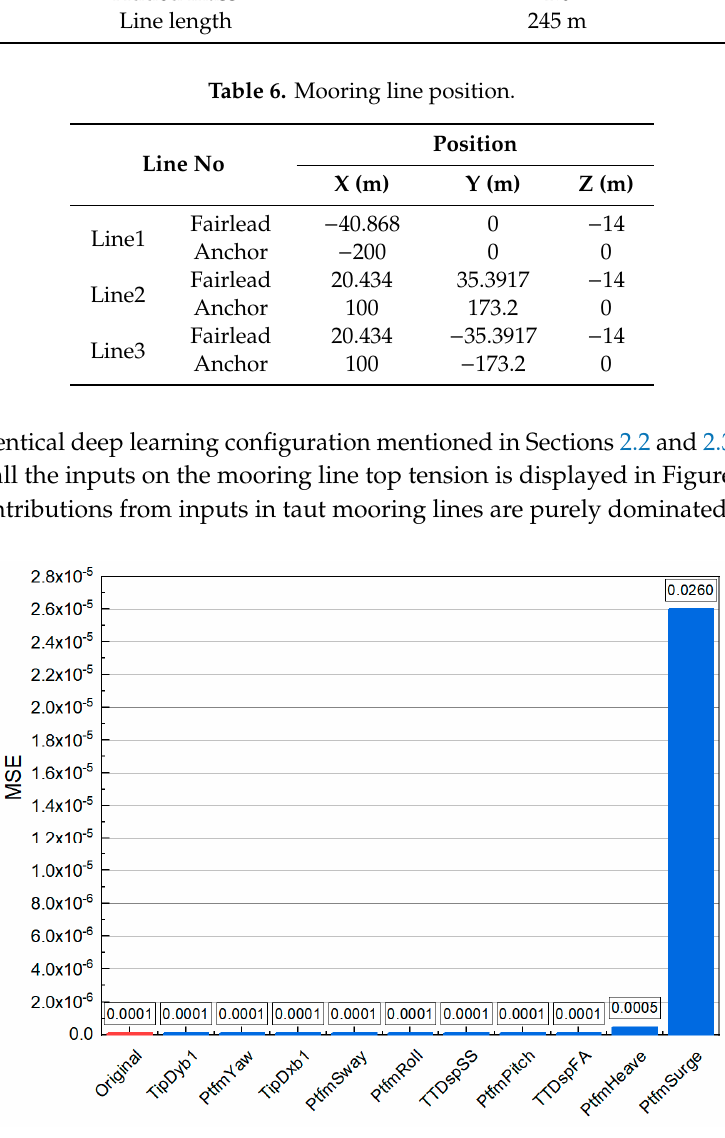
Figure 15. Level of significance (taut).